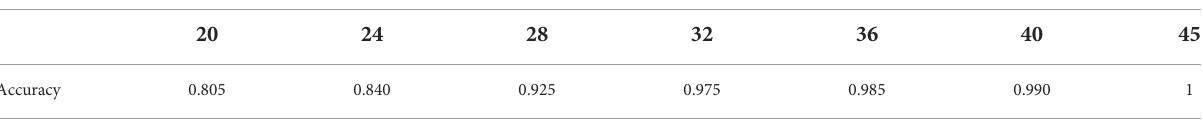
TABLE 3 Accuracy of the identi fi cation of decayers.